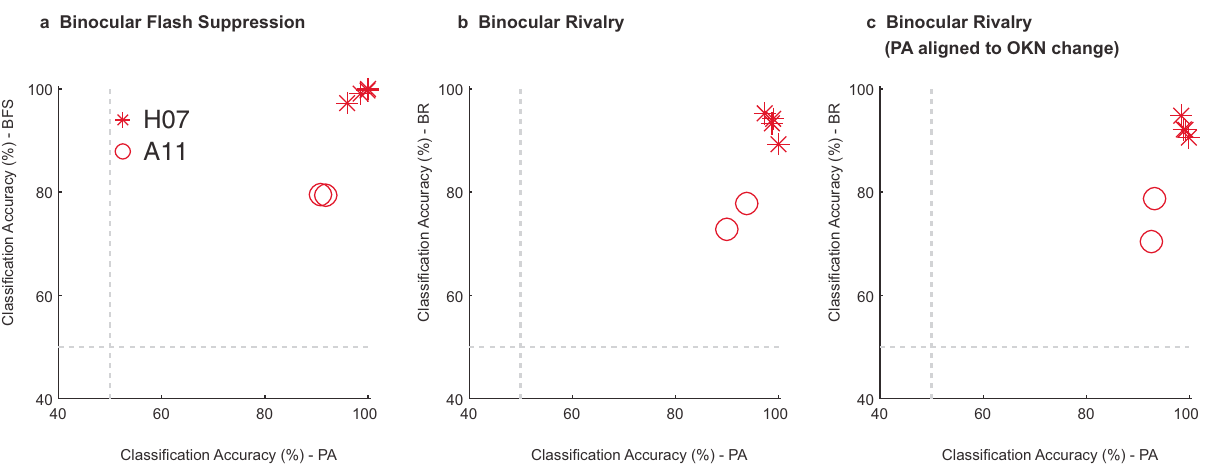
Fig. 4 Assessment of decoding within individual datasets. This fi gure displays the classi fi cation accuracy at the level of individual recording sessions performed across the two animals: four sessions of H07 (red asterisks) and two sessions for A11 (red circles). Each point in the scatter plot corresponds to classi fi cation accuracy during PA or BR trials, obtained in a given dataset. The three panels present the results obtained across the different temporal phases of the paradigm: a , fl ash dominance, b , rivalry dominance, wherein PA trials are aligned to the physical stimulus change and c , rivalry dominance, wherein PA trials were aligned to the change in OKN. The results are computed over an 800 ms window starting 200 ms after the event used for aligning the data (physical stimulus change, or OKN derived change). We note that the classi fi cation accuracy for BR in b and c are similar but not identical, because they were obtained using two separate runs of the decoding analysis. In general, we observed strong classi fi cation accuracy even at the level of individual